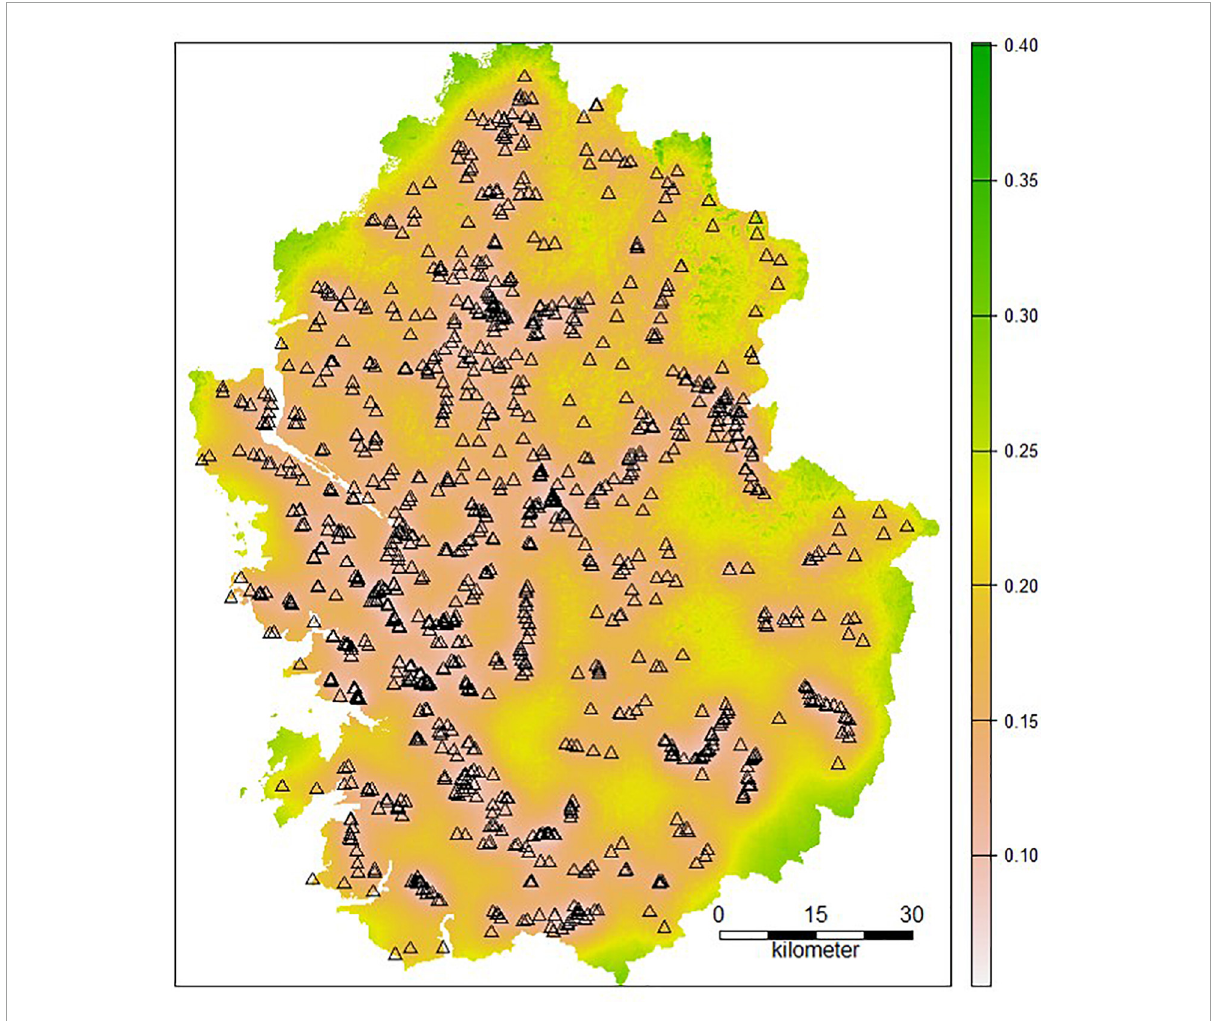
FIGURE5 Regression kriging (RK) variance map of Ambrosia trifida (Triangles present sampling